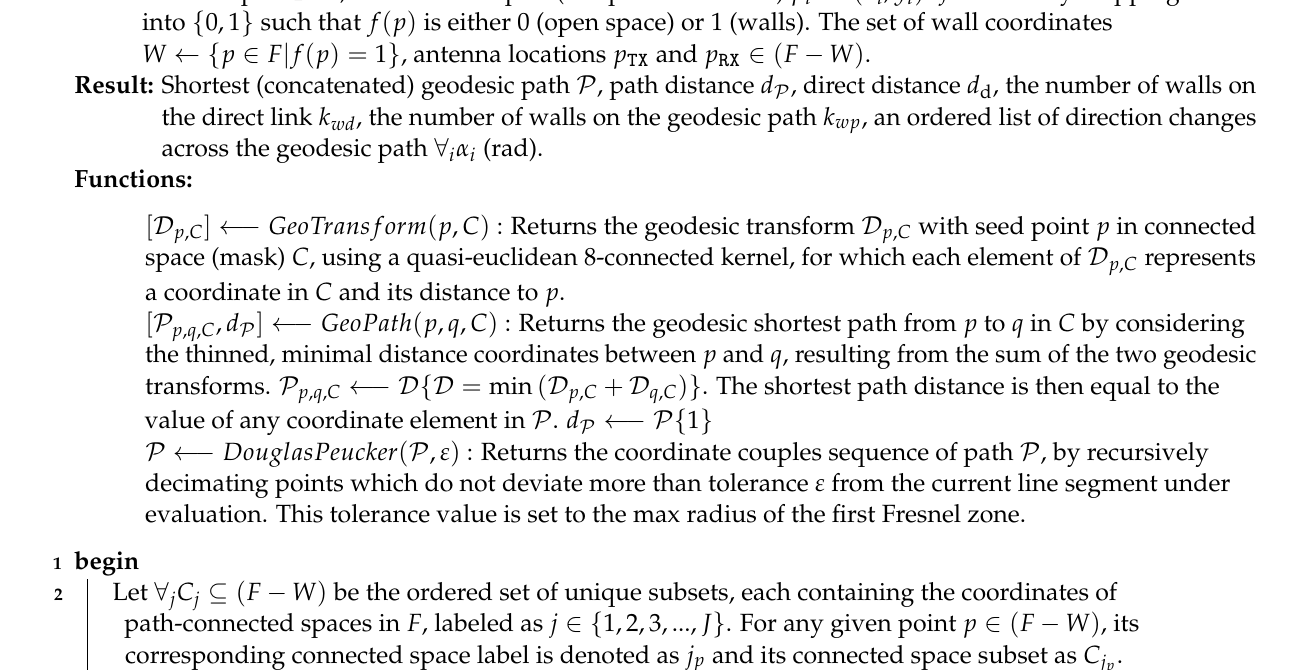
( x ) . f is a binary mapping of i ← i , y i